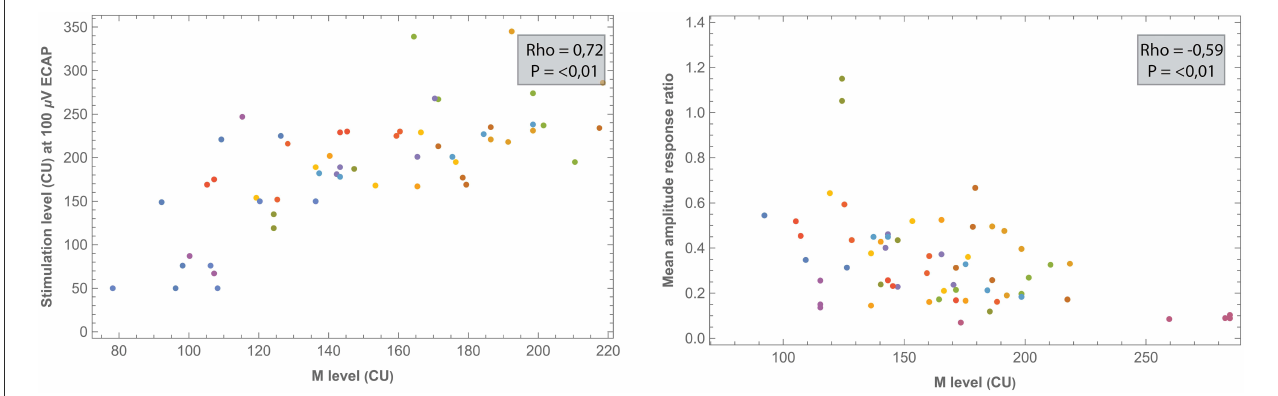
FIGURE9 Comparisons between ECAP parameters and measured M levels. All measurements were recorded 1 week after CI activation. Each subject (contributing five data points if no missing values) is represented by a different